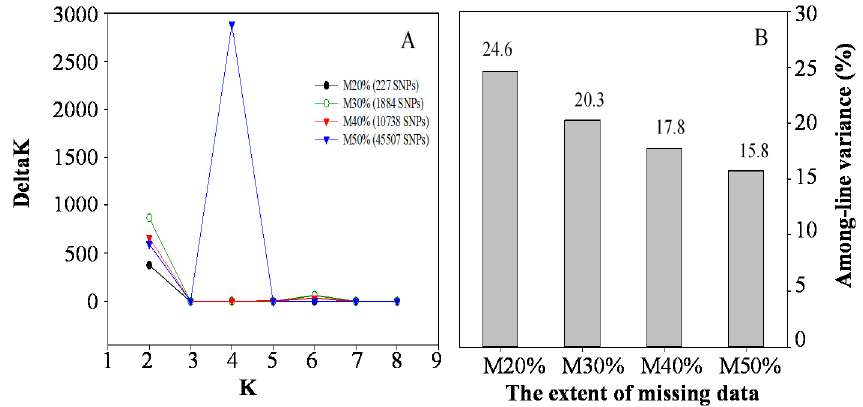
Figure 6. The impact of missing SNP data on the inferences of STRUCTURE and AMOVA analysis. The left panel ( A ) shows the four optimal clusters obtained from the STRUCTURE analyses at the missing level of M20% and M50%, and six clusters at M30% and M40%. The right panel ( B ) shows the SNP variances, ranging from 24.6 to 15.78%, inferred from AMOVA analyses residing among 12 lines at the increasing level of missing values from M20% to M50%, respectively.